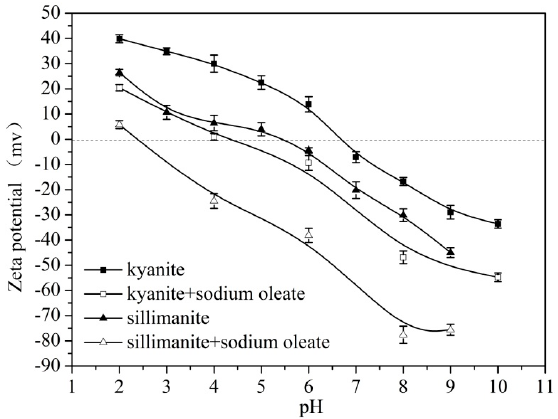
Figure 8. Zeta potentials of kyanite and sillimanite as a function of pH. Error bars represent mean values of three tests ± standard deviation.